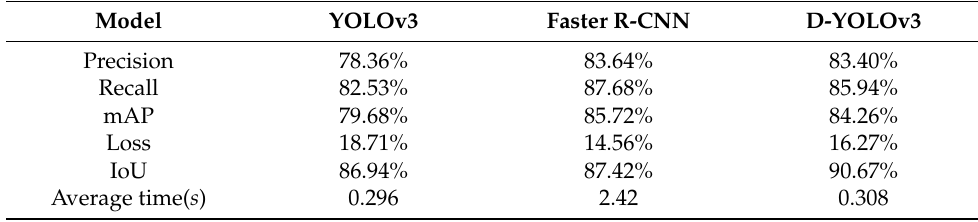
Table 2. Test comparison for three